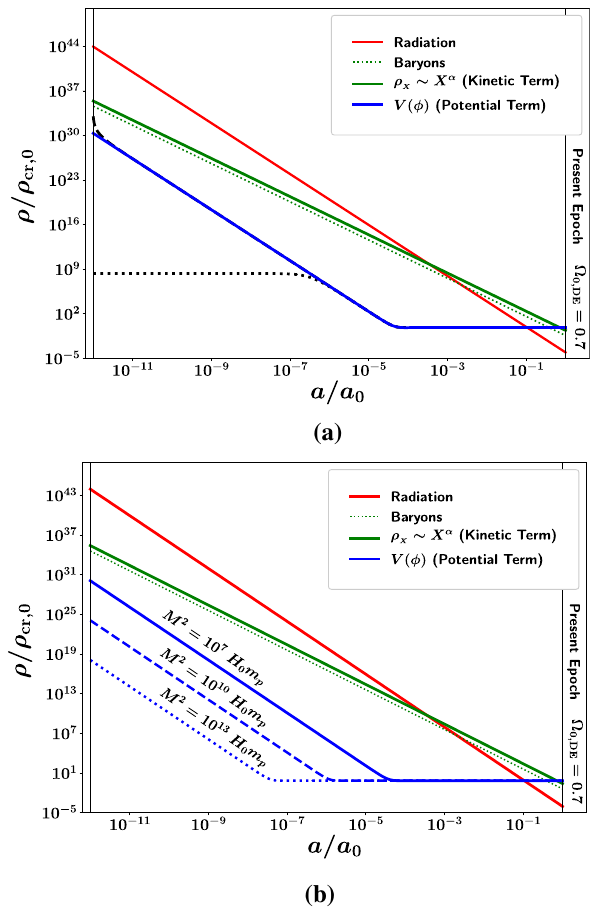
Fig. 2 a The evolution of the density (in units of ρ cr , 0 = 3 m 2 p H 2 ) is 0 ∝ X α shownforradiation(red),baryons(dottedgreen),kineticterm ρ X (solid green) and the potential V (φ) (solid blue) for V (φ) ∝ coth 2 φ . Note that dark matter is sourced by the kinetic term which always drops ∝ a − 3 , regardless of the shape of the potential. DE is sourced off as ρ X by V (φ) which initially scales like the background fluid, V ∝ ρ , B before flattening to a constant value V 0 . The dotted and dashed black curves correspond to different initial values of V (φ) and indicate that a largerangeofinitialconditionsconvergeontothescalingattractor(solid blue), yielding Ω 0 , DE = 0 . 7 at the present epoch. b Same as the top panel except that results for three different values of the non-canonical parameter M are shown. Note that dark matter (solid green), sourced ∝ a − 3 , regardless of the by the kinetic term, always drops off as ρ X value of M . By contrast the value of V (φ) depends quite sensitively on M , see (20). In all cases V (φ) initially scales like the background fluid, V ∝ ρ , before flattening to the constant value V (φ) (cid:2) V 0 . Late time B expansion in this model resembles Λ CDM